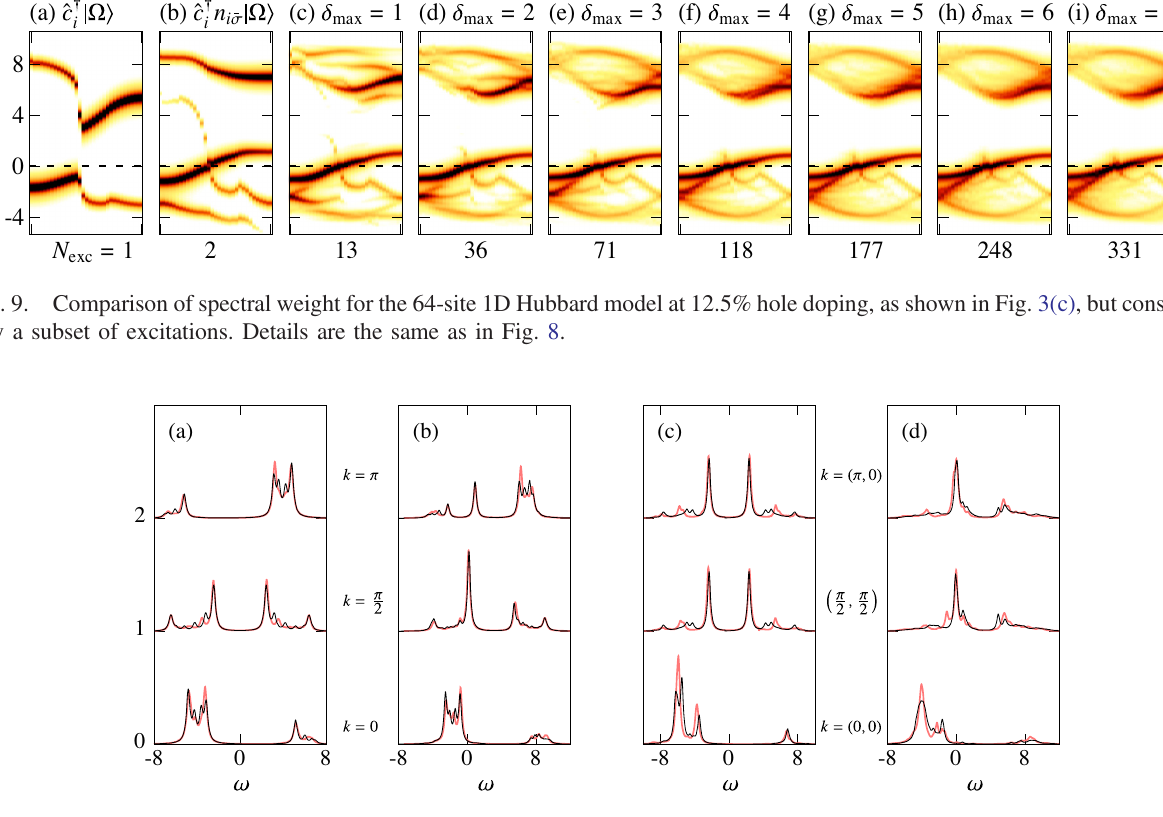
FIG. 10. Comparison between A ð k; ω Þ obtained from ED (thin black line) and dVMC (thick red line) corresponding to (a) the first two panels of Fig. 2(b) Fig. 3(c) Fig. 5, and (d) Fig. 6. We only show a selection of the most relevant k points, namely, k ¼ 0 , π = 2 , π for panels (a) and (b) and k ¼ ð 0 ; 0 Þ , ð π = 2 ; π = 2 Þ , ð π ; 0 Þ for panels (c) and